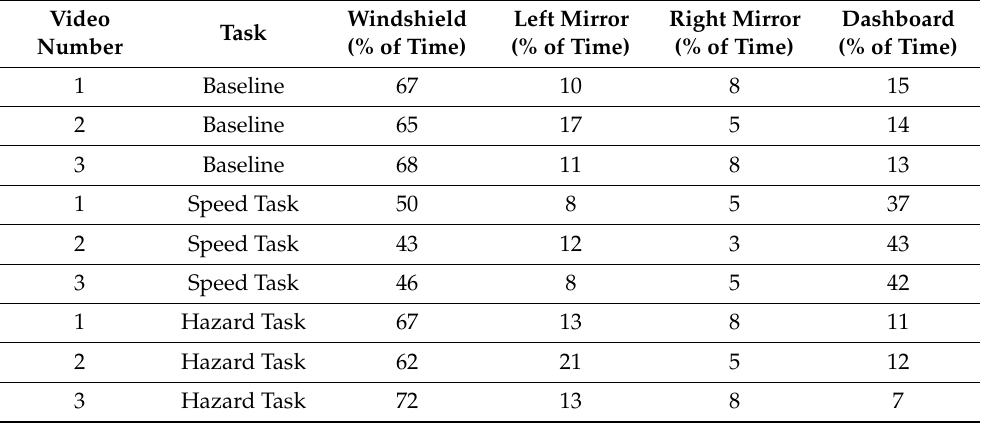
Table 1. Attention distribution to the four Areas of Interest (AOIs) for the nine trials.